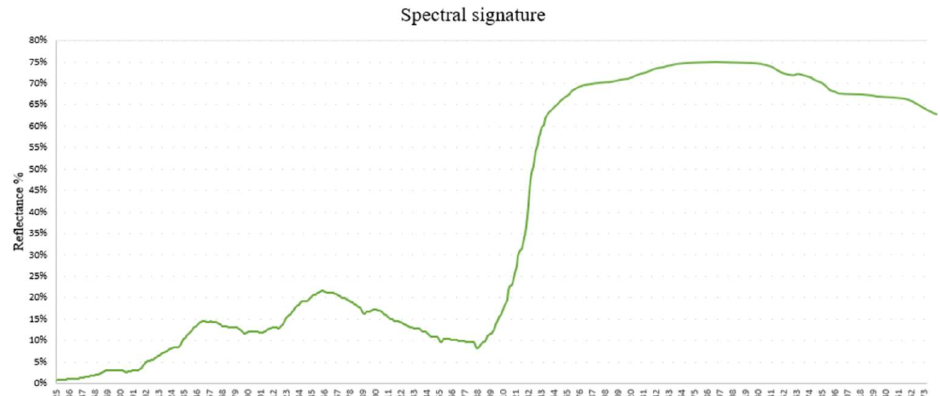
Figure 1. Spectral signature of the olive